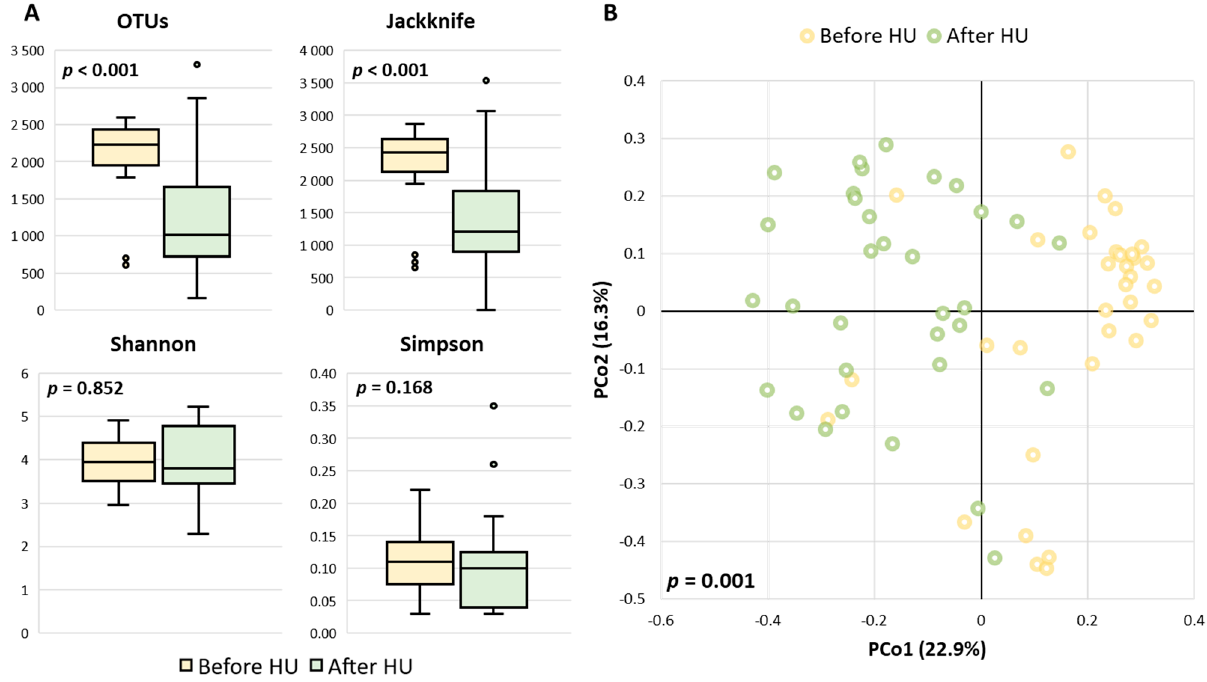
Figure 1. ( A ) Boxplots of operational taxonomic units (OTUs) observed and species richness (Jackknife index) and diversity performed with Shannon and Simpson indexes. Alpha-diversity analysis was conducted using the Wilcoxon test; ( B ) Principal-coordinate analysis (PCoA) based on Bray–Curtis distances at genus level showing a clustering pattern between the two groups. Beta-significance was calculated by the PERMANOVA test, and the percentage of variation explained by the principal coordinates (PCo1 and PCo2) is indicated on the axes.